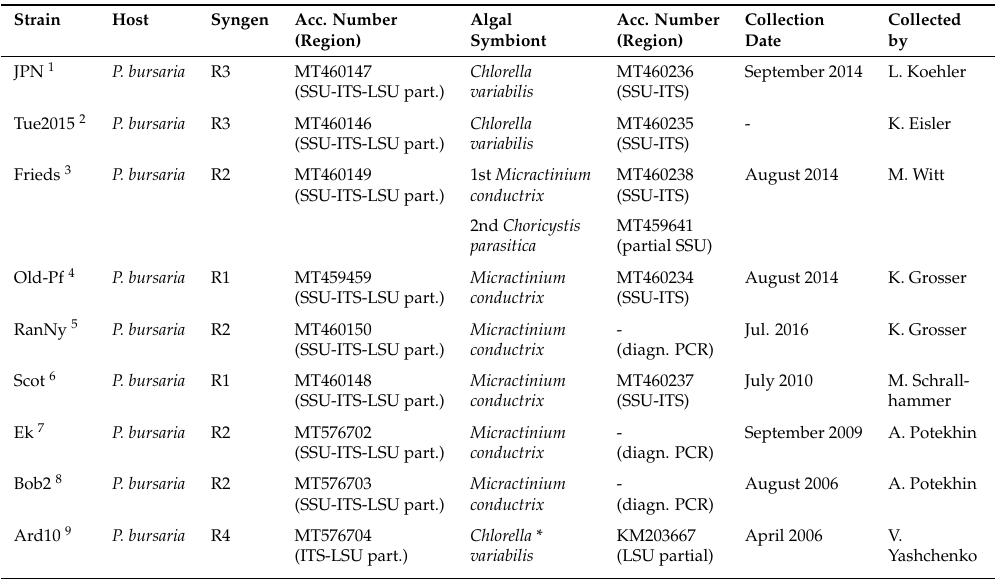
Table 1. Paramecium bursaria and algal strains used in this study. Obtained sequences and their accession numbers are